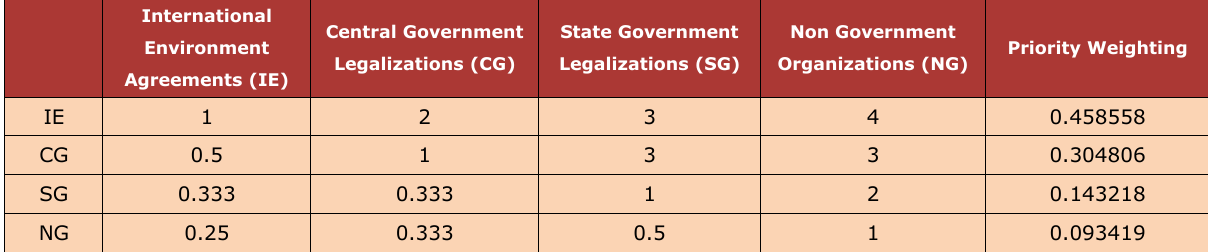
Table 3. Strategies of Non members of supply chain (Dimension